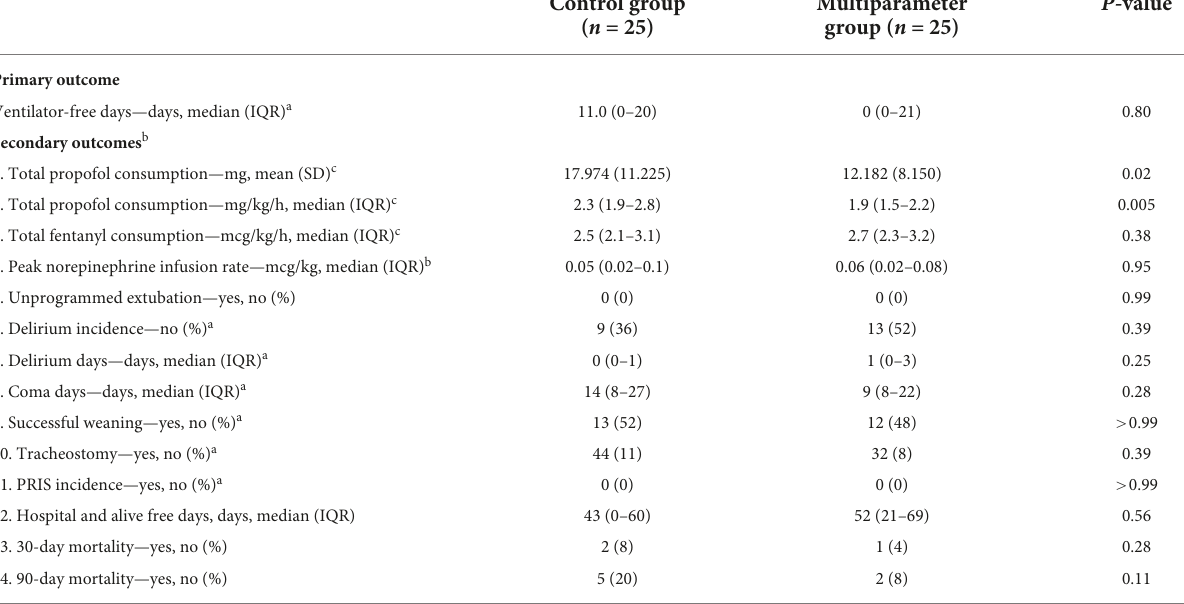
a Atday30. b LevelofsignificanceadjustedwithBonfenorri’scorrectiontobe0.005atday90. c Duringthefirst5daysafterrandomization.